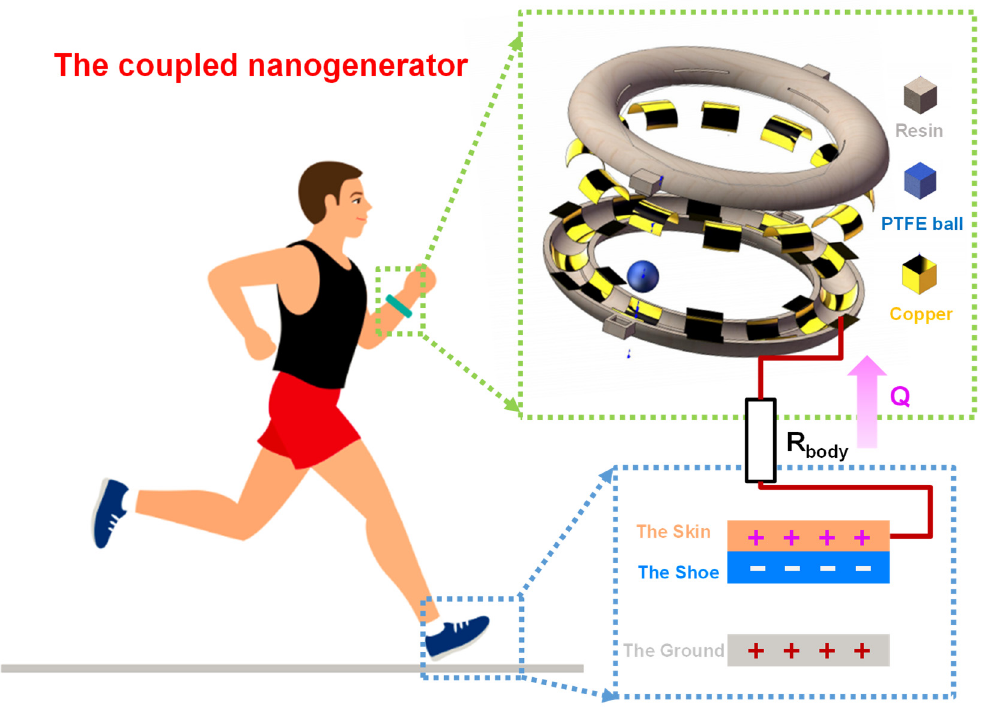
Figure 1. Schematic diagram of the energy harvester coupled with the triboelectric mechanism and electrostatic mechanism for biomechanical energy harvesting.